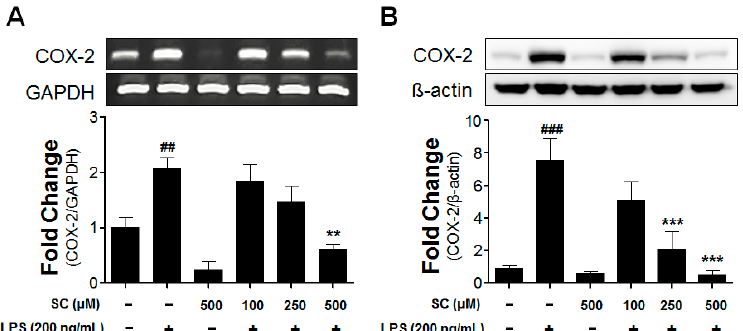
Figure 3. Effect of scoparone on LPS-induced COX-2-mRNA and COX-2-protein expressions in BV-2 microglial cells. The BV-2 microglial cells were seeded at 2.5 × 10 5 cells/mL, and were incubated for 6 h and 20 h with various concentrations of scoparone 1 h before the stimulation with LPS. The mRNA was first isolated, and the mRNA expression was then evaluated using the RT-PCR ( A ). The cell lysates were electrophoresed, and the COX-2 expressions were detected using a specific antibody ( B ). The data are the mean ± standard error ( n = 3) of three independent experiments. ## p < 0.01, ### p < 0.005, compared with the control group; ** p < 0.01 and *** p < 0.005 compared with the LPS-treated